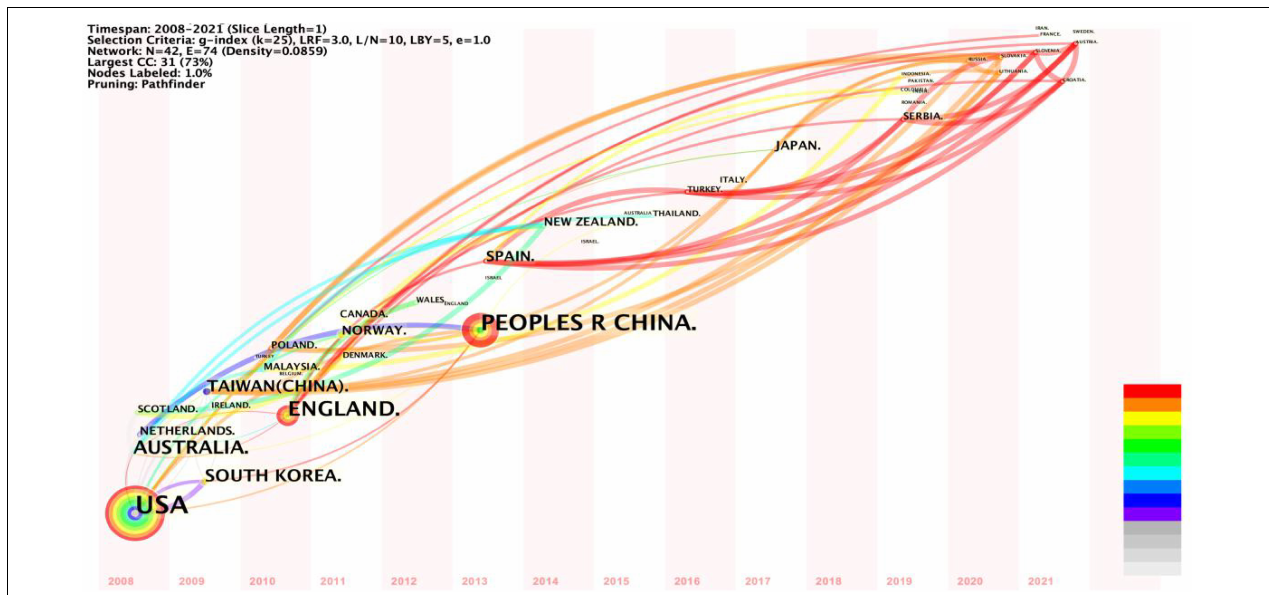
FIGURE 3 | A time-zone view of the country/region collaboration network.